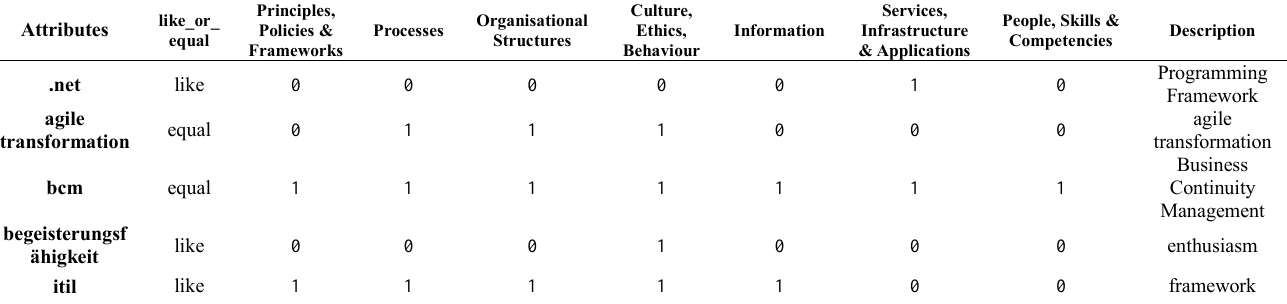
Table 1. Example of attributes and their categorisation